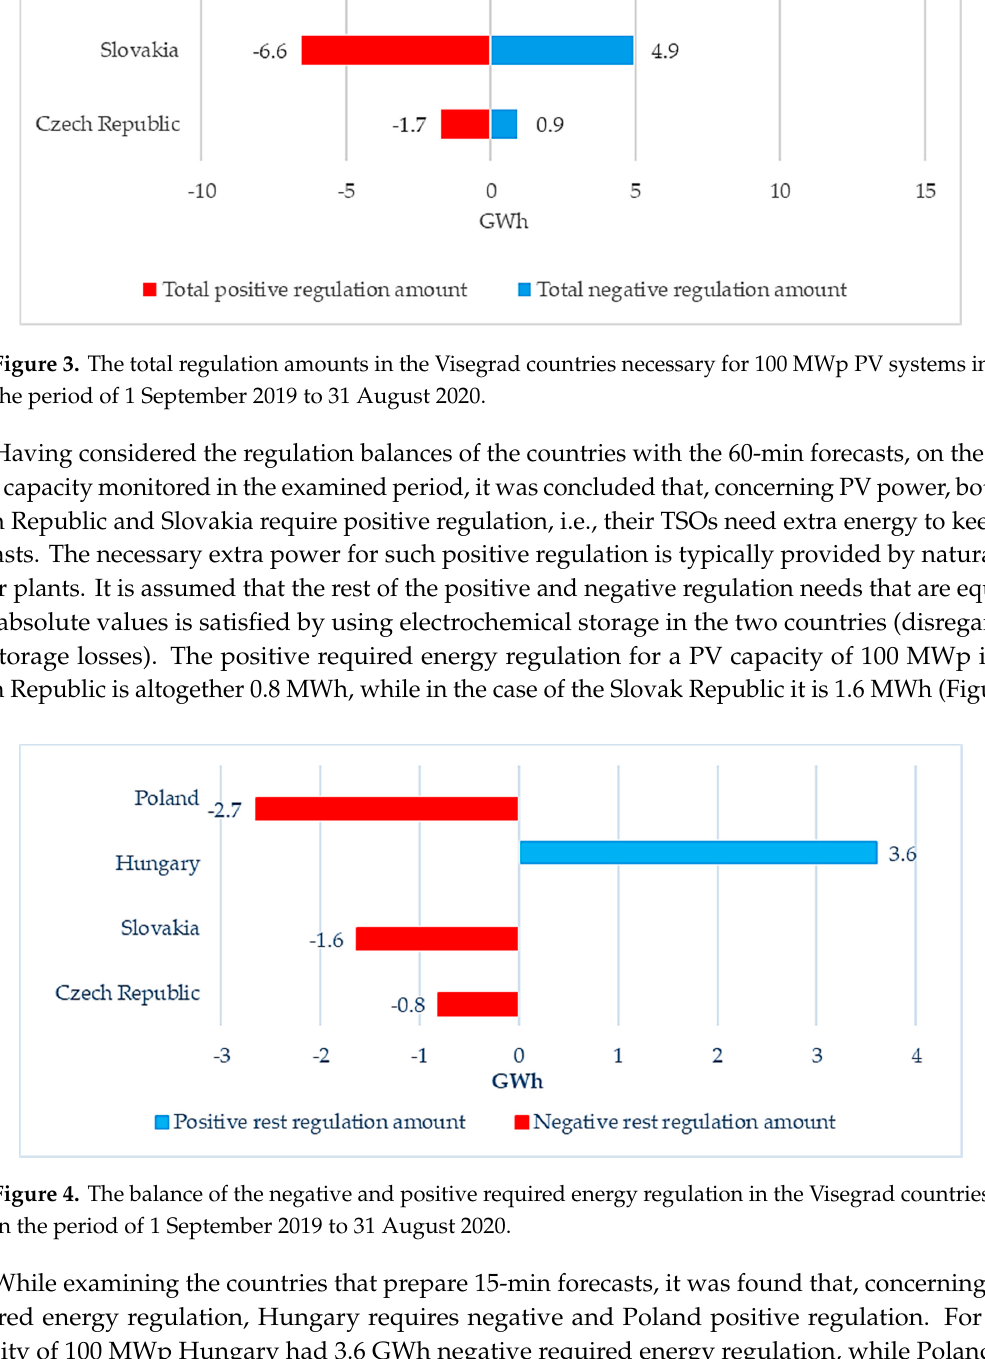
Figure 4. The balance of the negative and positive required energy regulation in the Visegrad